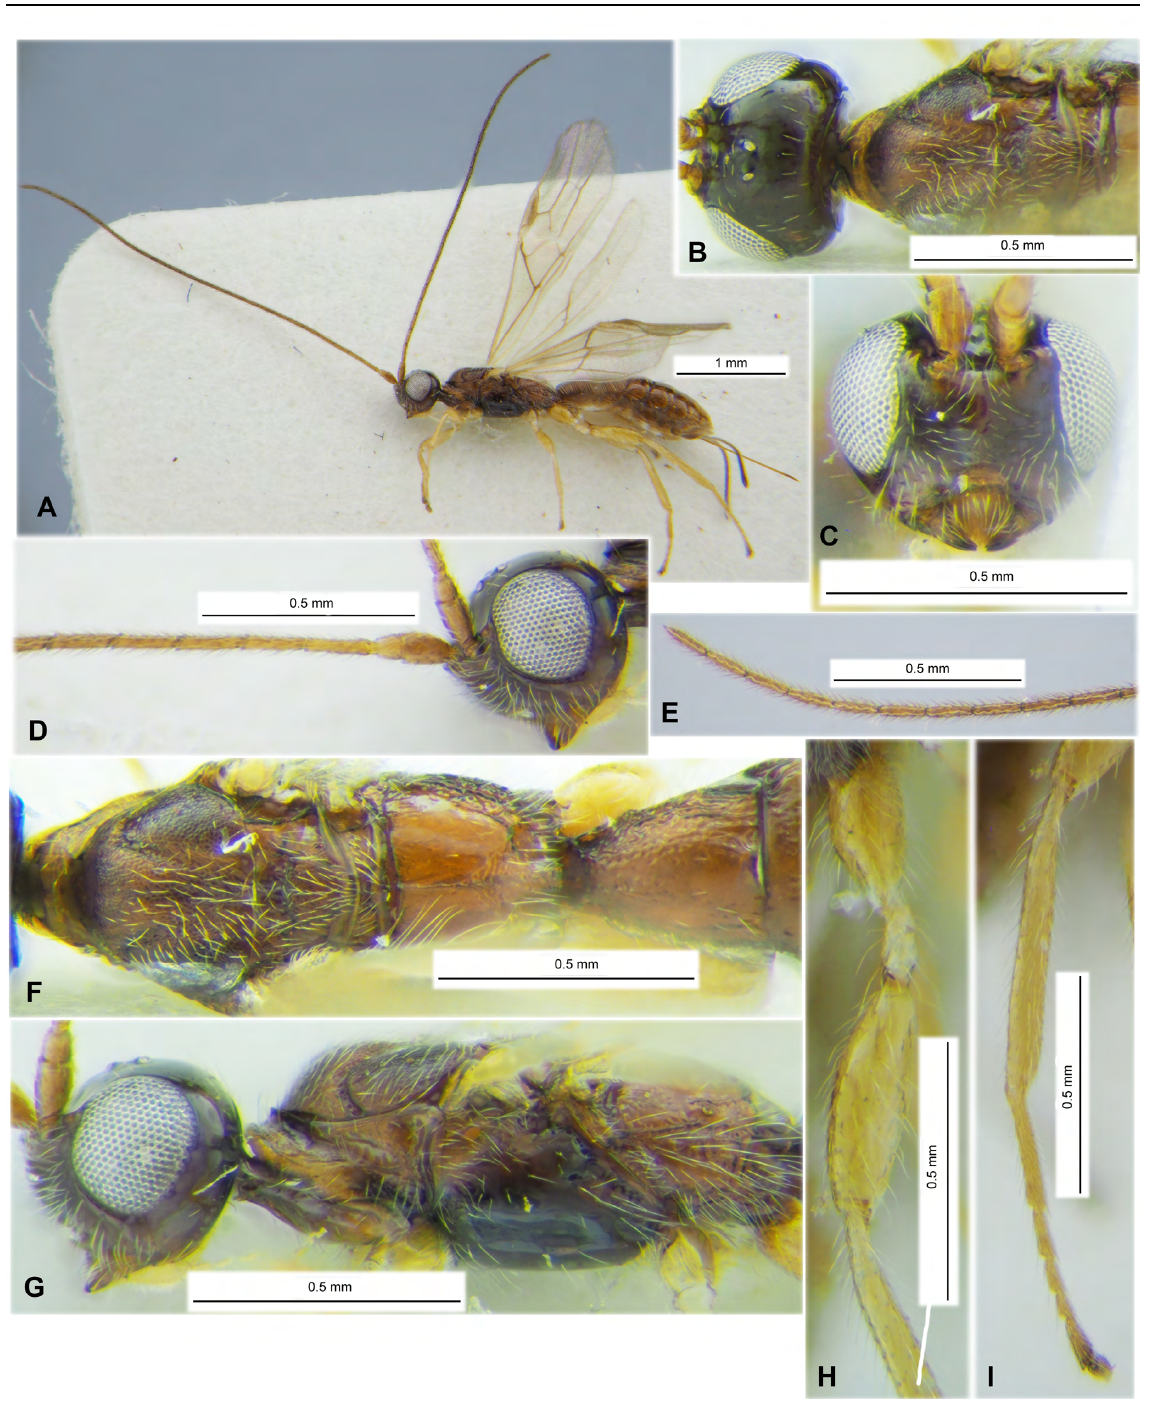
Fig. 20. Ipodoryctes ( Afroipodoryctes ) saintphilippensis sp. nov., ♀, holotype, MNHM. A . Habitus, lateral view. B . Head and mesoscutum, dorsal view. C . Head, front view. D . Head and basal segments of antenna, lateral view. E . Apical segments of antenna. F . Mesosoma and first metasomal tergite, dorsal view. G . Head and mesosoma, lateral view. H . Hind coxa and femur. I . Hind